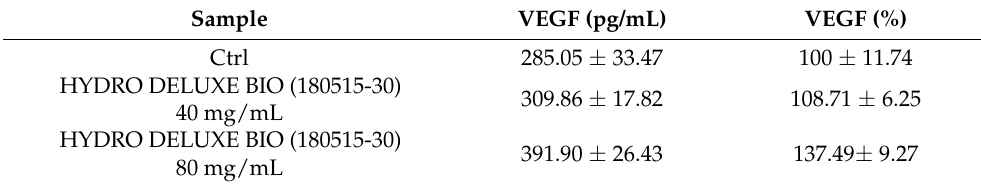
Figure 2. HYDRO DELUXE BIO treatment induces an increase in VEGF secretion at the highest tested concentration. Effect of 24 h treatment with the product HYDRO DELUXE BIO on VEGF secretion expressed as concentration in pg/mL ( a ) and as percentage ( b ). Ctrl: untreated cells; HYDRO DELUXE BIO: treated cells with 40 or 80 mg/mL. Values of * p ≤ 0.05 were considered statistically significant compared with Ctrl, following the statistical analysis with the one-way ANOVA method. Table 2. Values of VEGF levels, expressed as concentration and percentage, in HaCaT cells after treatment with the product HYDRO DELUXE BIO compared to control.